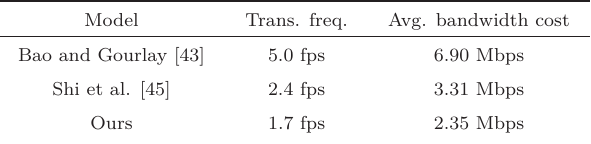
Table 7 Transmission frequency and average bandwidth cost of different reference viewpoint selection models Model Trans.